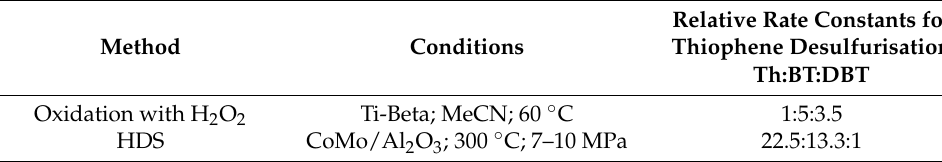
Table 2. Sulfoxidation and HDS reactivity of thiophenes [26].